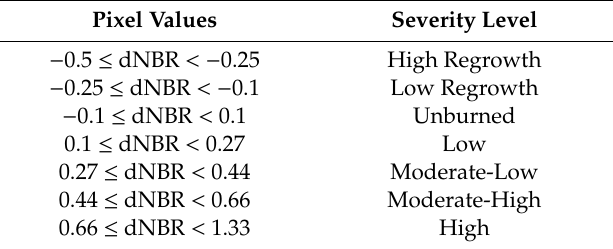
Table 1. Di ff erences in normalized burn ratio (dNBR) classification proposed by the United States Geological Survey